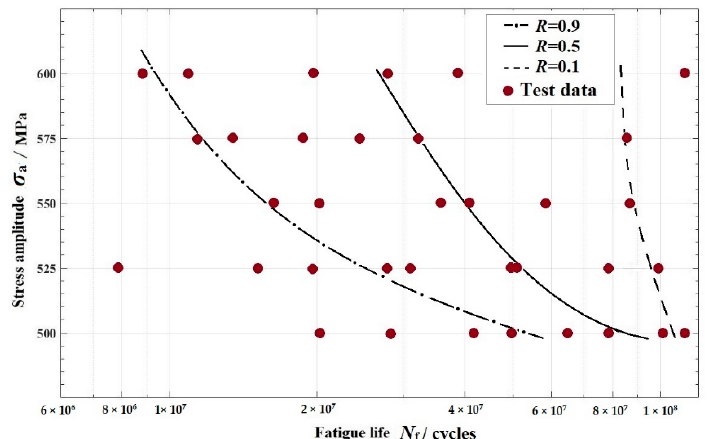
Figure 8. P-S-N curves with the R = 0.1, 0.5, 0.9.